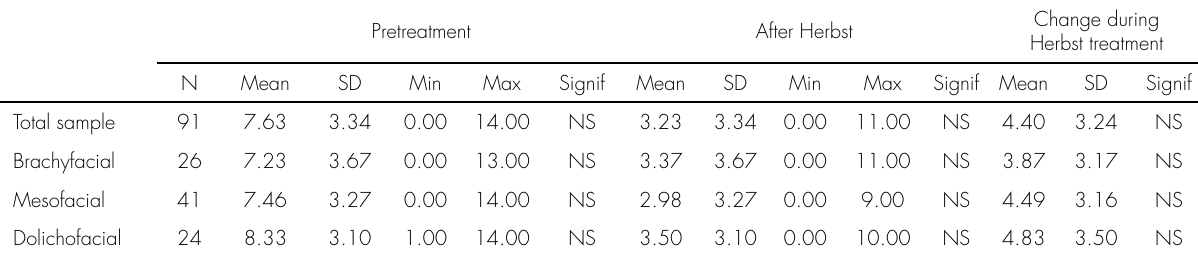
Table V. Incisal overjet (mm).